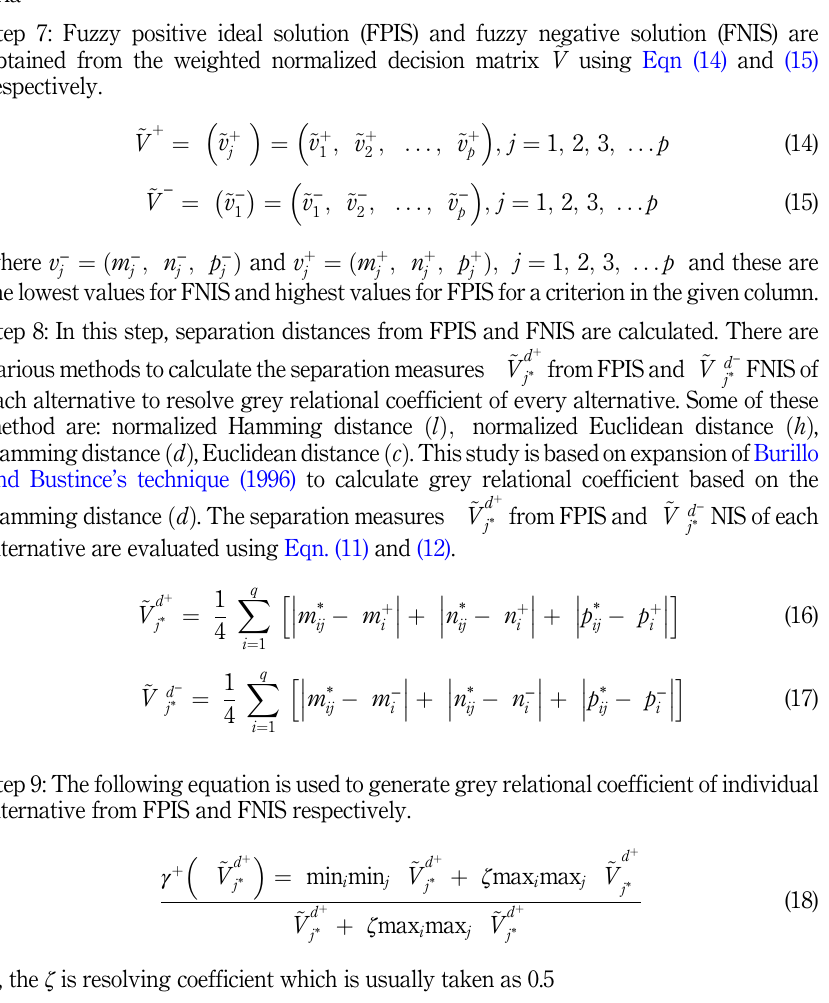
Here, the ζ is resolving coefficient which is usually taken as 0.5